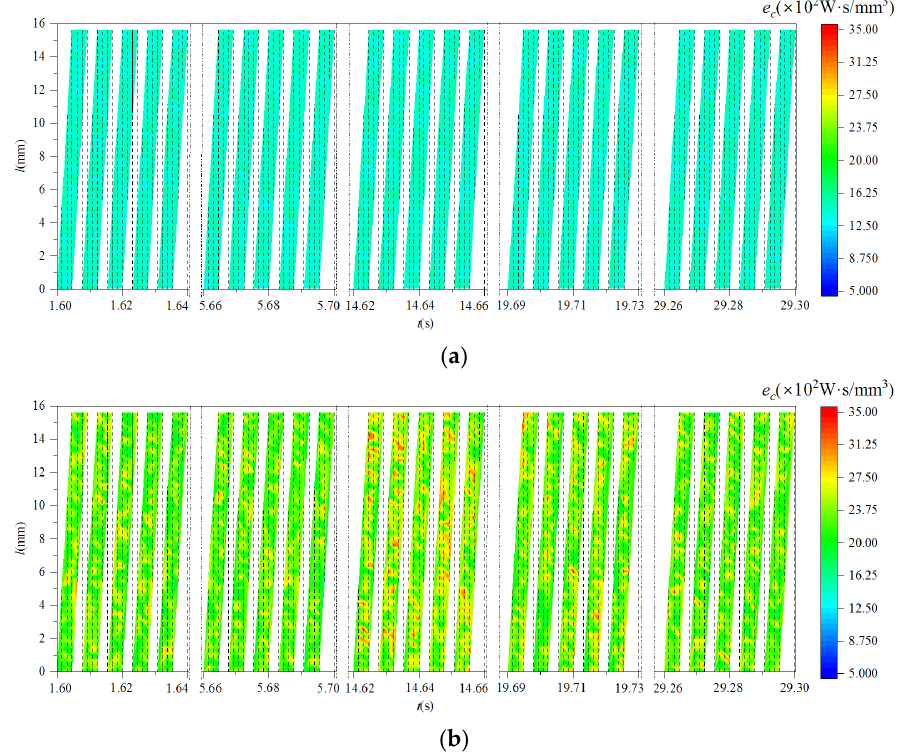
Figure 16. The distributive variation in instantaneous specific tangential-force energy of cutting edge with and without vibration. ( a ) Without milling vibration; ( b ) with milling vibration.